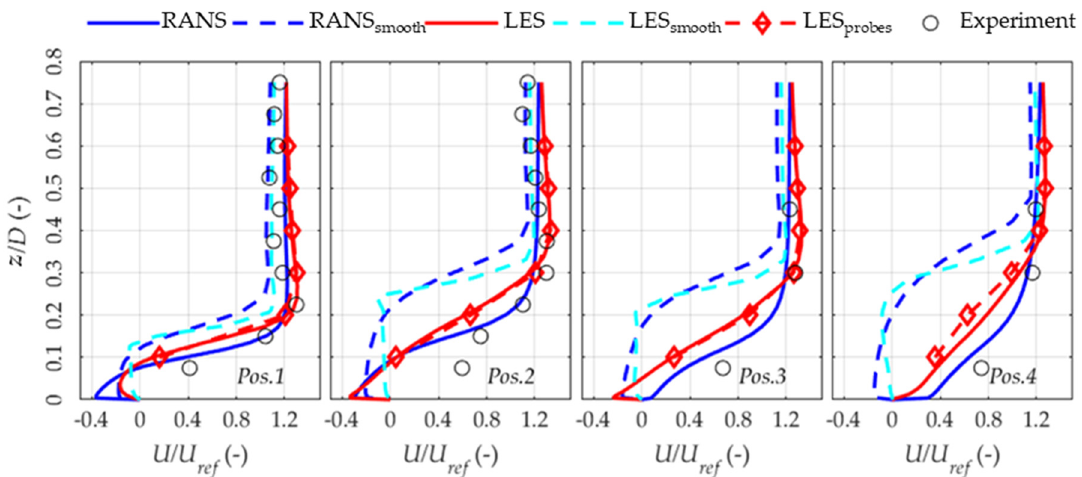
Figure 8. Longitudinal mean velocity values ( U ) for positions 1, 2, 3, and 4 normalized against U ref . The continuous line refers to the turbulent inlet, and the dashed one to the smooth inlet. LES results were computed using both ensemble averages and time averages from probes for comparison.